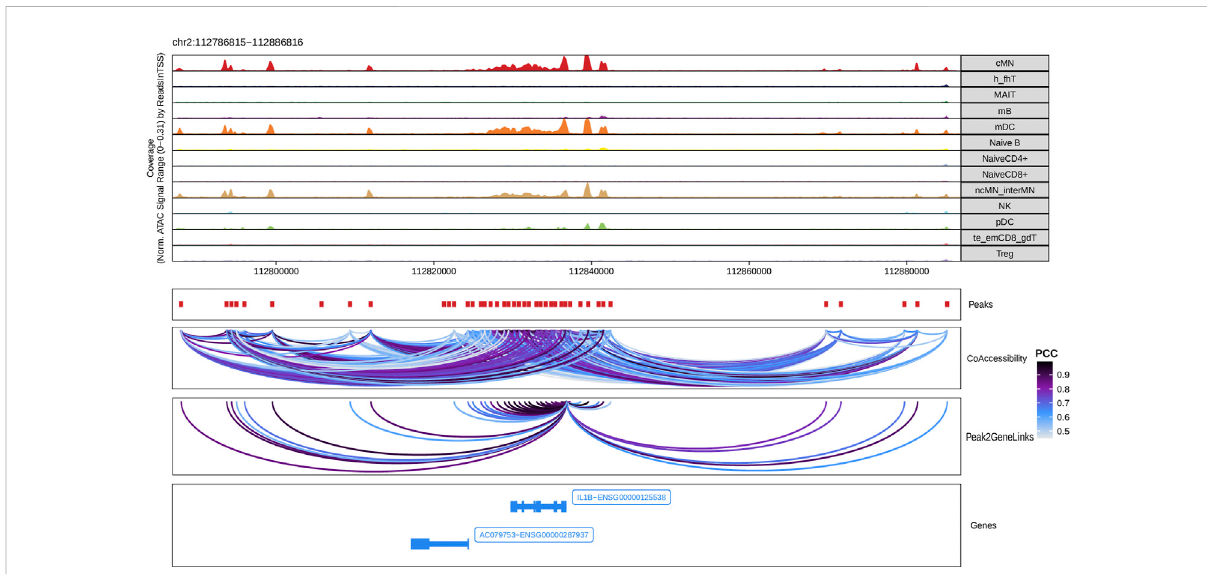
FIGURE 5 Co-accessibility and peak-to-gene links in a IL1B -containing genomic region. The top panel shows the normalized read coverage in the genomic region of each cell type. The second panel shows peaks represented by red boxes. The third panel shows peak pairs, linked by colored arches, with co-accessibility scores (Pearson correlation coef fi cients) greater than 0.5. The fourth panel shows peaks linked to the IL1B promoter peak with co-accessibility score greater than 0.5. The fi fth panel shows gene models of IL1B and AC079753 in this